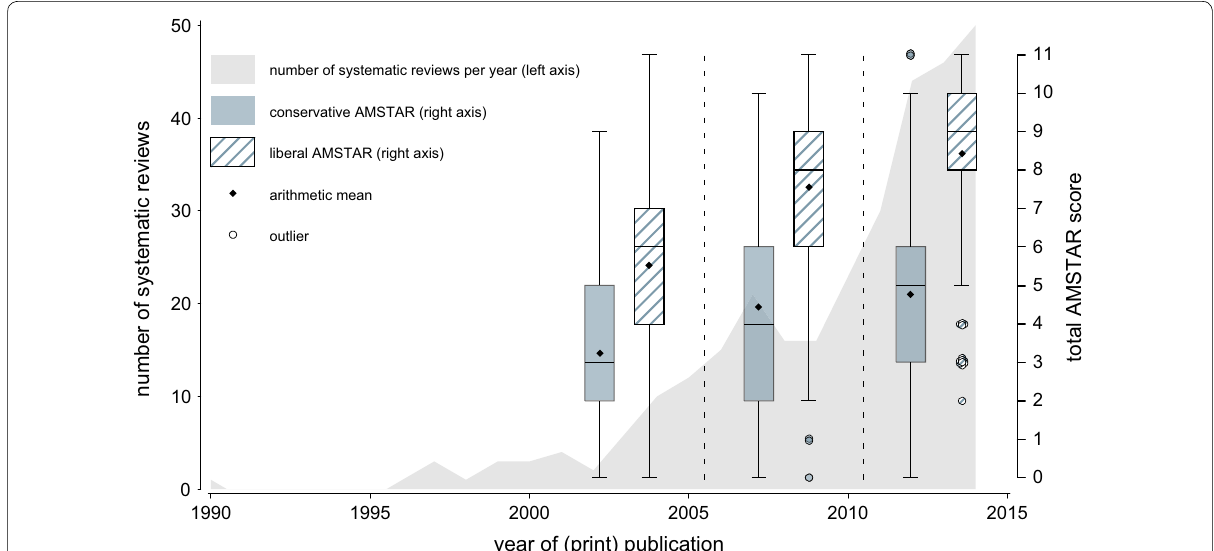
Fig. 2 Box plots of AMSTAR scores over periods of publication. The lower box margin indicates the 1st quartile; the upper box margin indicates the 3rd quartile. The vertical line within the box indicates the median. Whiskers are drawn at the most extreme value within a distance of 1.5-times the interquartile range from the respective box margin. Multiple outliers at the same value are